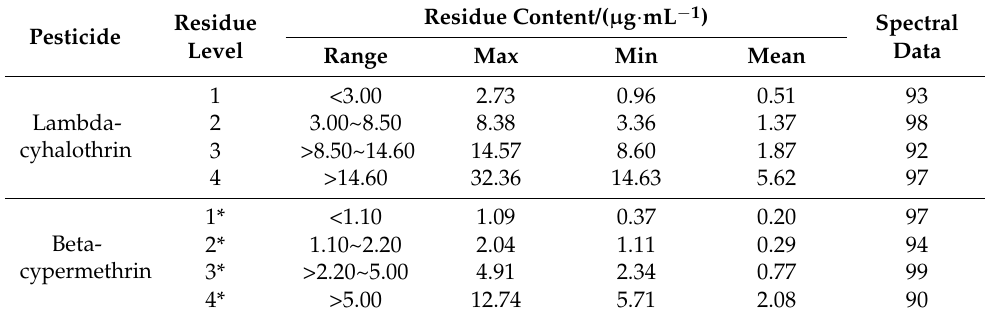
Table 5. Spectral data distribution in four-level discrimination of pesticide